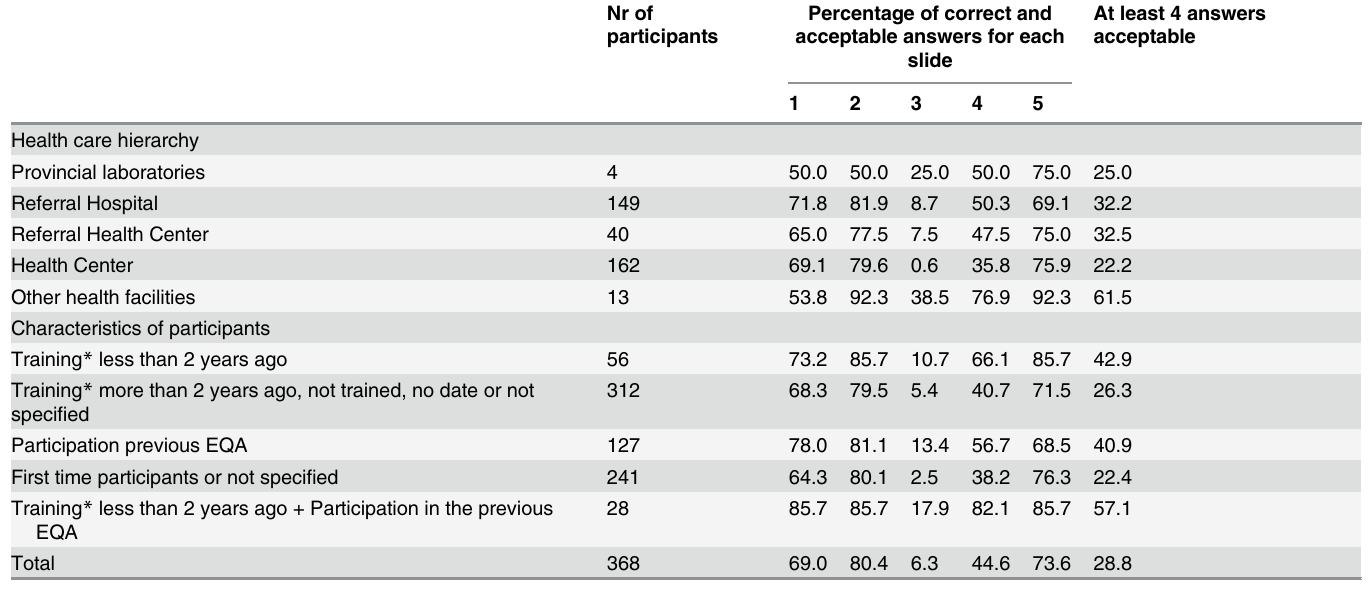
Table 3. Participants reporting and correct answers according to the health care hierarchy, participating in recent training and in previous